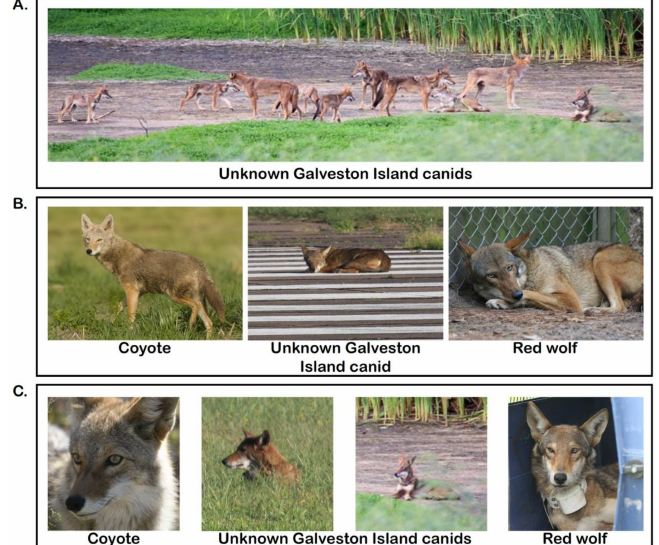
Figure 2. Photographic comparison of coyotes, Galveston Island (GI) canids, and red wolves. Photo credit and location as follows: ( A ) Pack of GI canids, Galveston Island, TX, credit: R. Wooten. ( B ) Western coyote, Intermountain West, United States, credit: Wikimedia commons, Rich Keen/DPRA. GI canid laying on airport runway, Galveston Island, TX, credit: R. Wooten. Captive female red wolf, Alligator River National Wildlife Refuge, NC, credit: R. Nordsven, USFWS. ( C ) Western coyote, Joshua Tree National Park, CA, credit: Wikimedia commons, Michael Vamstad/NPS. Headshots of GI canids, Galveston Island, TX, credit: R. Wooten. Wild juvenile male red wolf prior to release, Albemarle Peninsula, NC, credit R. Nordsven,